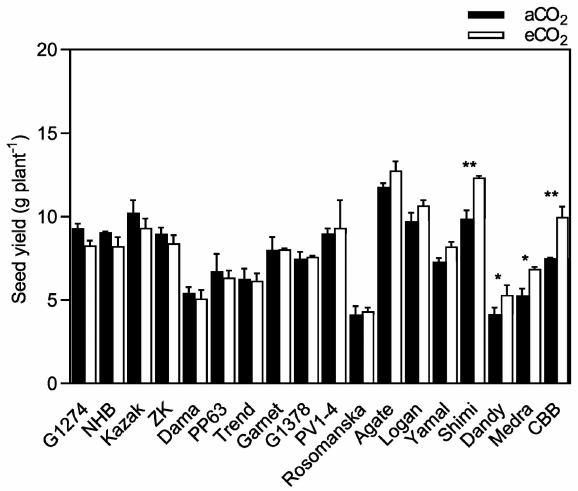
Figure 1. Seed yield of bean grown under ambient CO 2 (aCO 2 ) (400 ppm) and elevated CO 2 (eCO 2 ) (800 ppm). Data are means ± SE ( n = 10 plants). From left to right, varieties are classified in order of increasing seed yield responsiveness to eCO 2 . ** p < 0.01; * p < 0.05 significance level. Table 1. Growth and reproductive characteristics at maturity of 18 bean varieties grown at ambient (400 ppm) and elevated (800 ppm) CO 2 , and correlations (Pearson’s r) and their statistical significance for the relationship between the relative increase in bean seed yield due to eCO 2 (value at eCO 2 / value at aCO 2 ) and values of other parameters measured under the same conditions. * p < 0.05; ** p < 0.01; *** p < 0.001; **** p < 0.0001. C x V, CO 2 x variety interaction; ns, not significant. Mean CO 2 Parameter CO 2 Variety C x V E ff ect